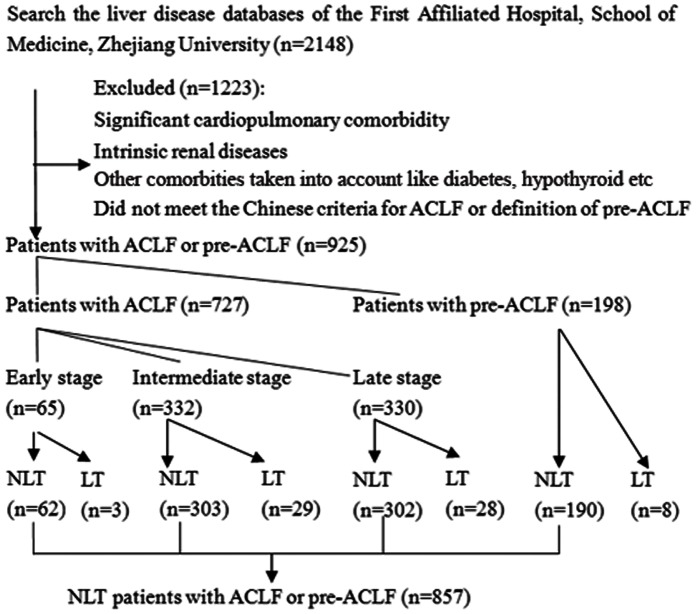
Flowchart of the study group selection process.LT: patients underwent liver transplantation; NLT: patients without liver transplantation.